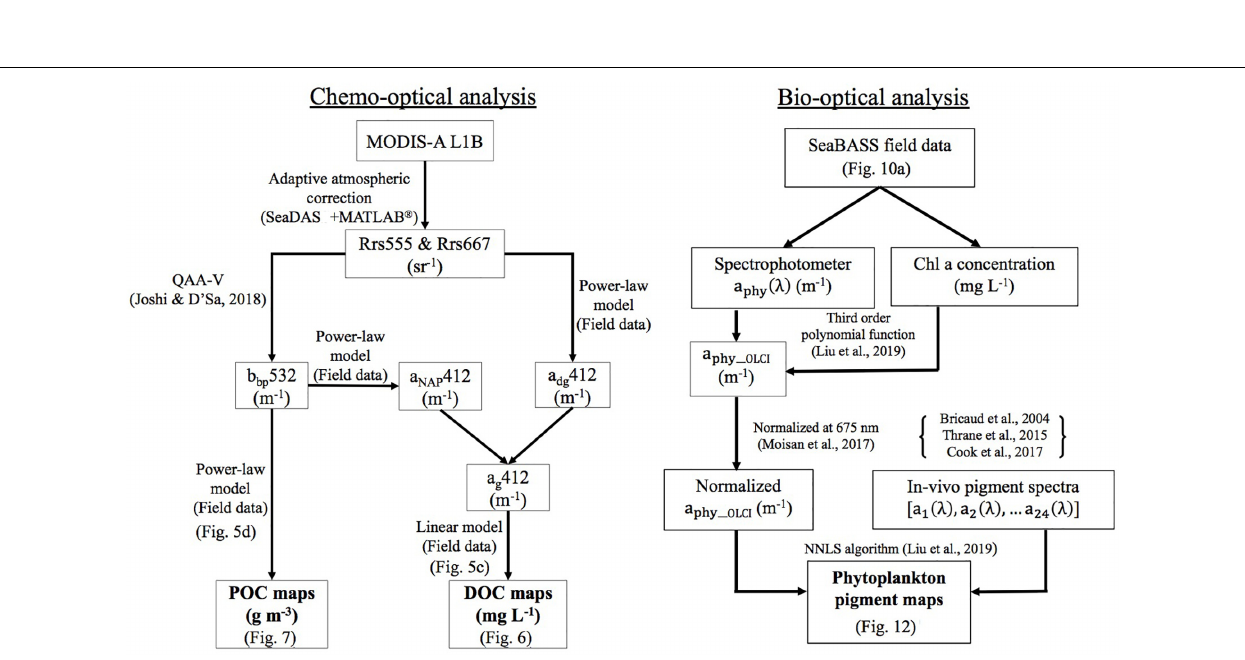
Frontiers in Marine Science |